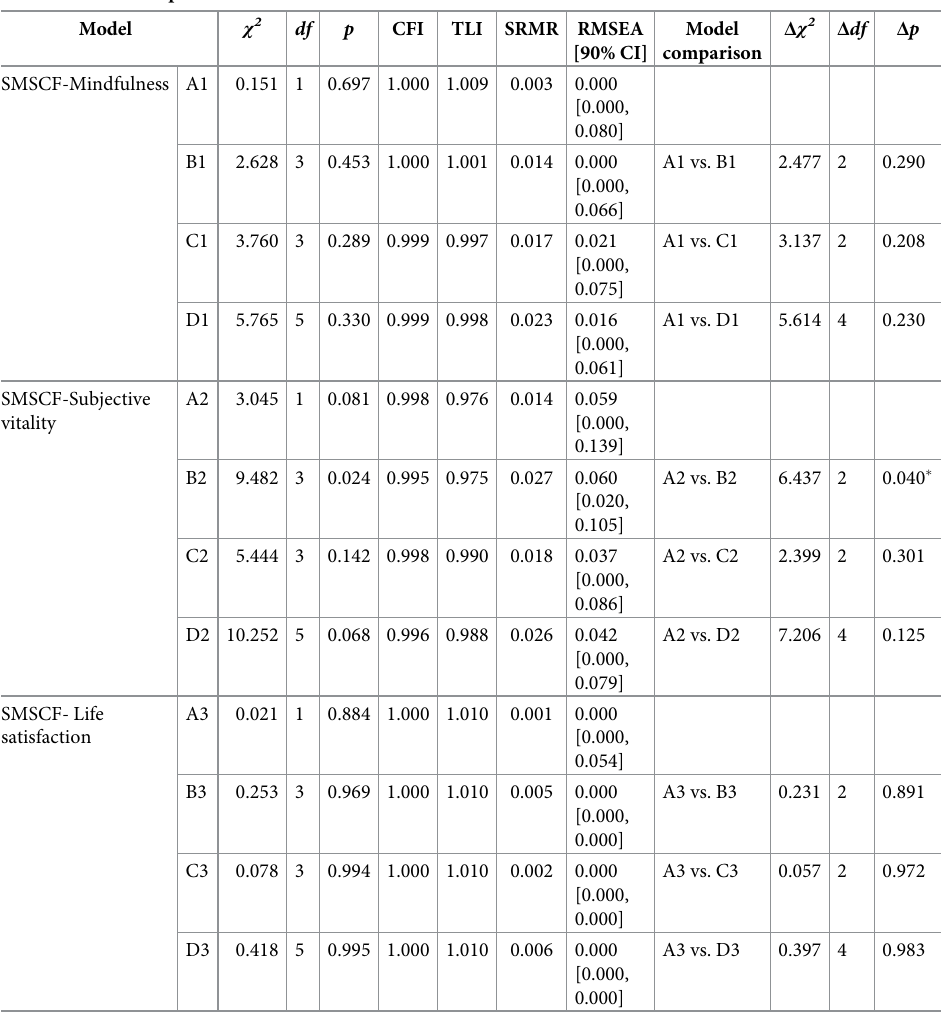
Table 5. Model comparisons for different constraint conditions.